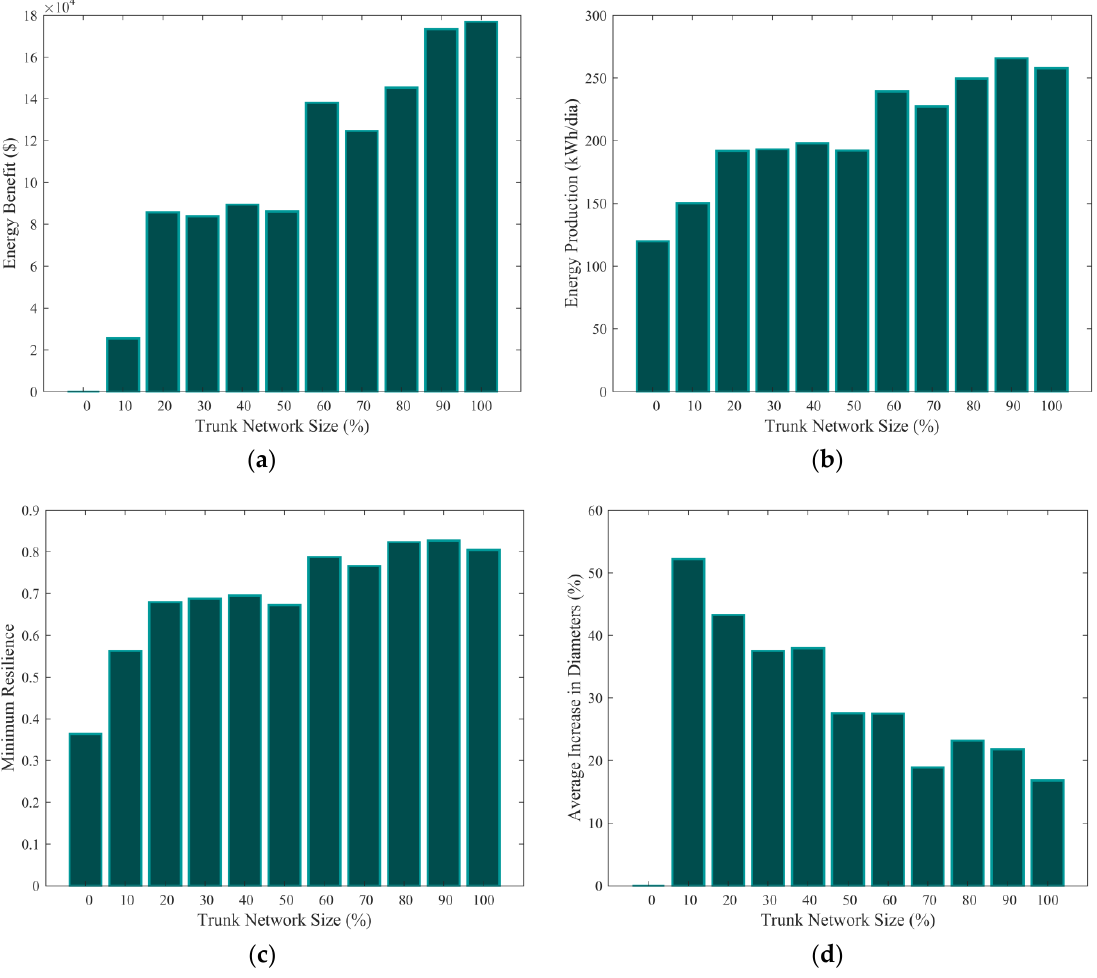
Figure 8. Results of TN rehabilitation for the Fossolo network: ( a ) Energy benefit; ( b ) Energy produced; ( c ) Minimum resilience; and, ( d ) Average increase in pipe diameters.